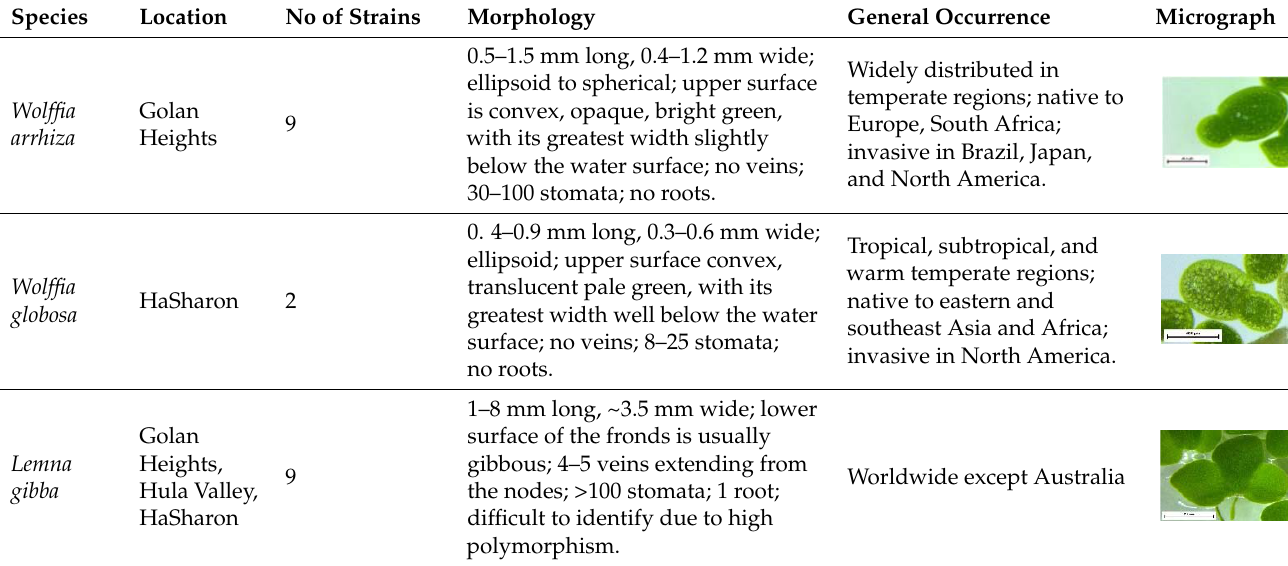
Table 1. Identification characteristics of duckweed species found in this study [1,2]. Images were taken using an epi-fluorescent microscope.